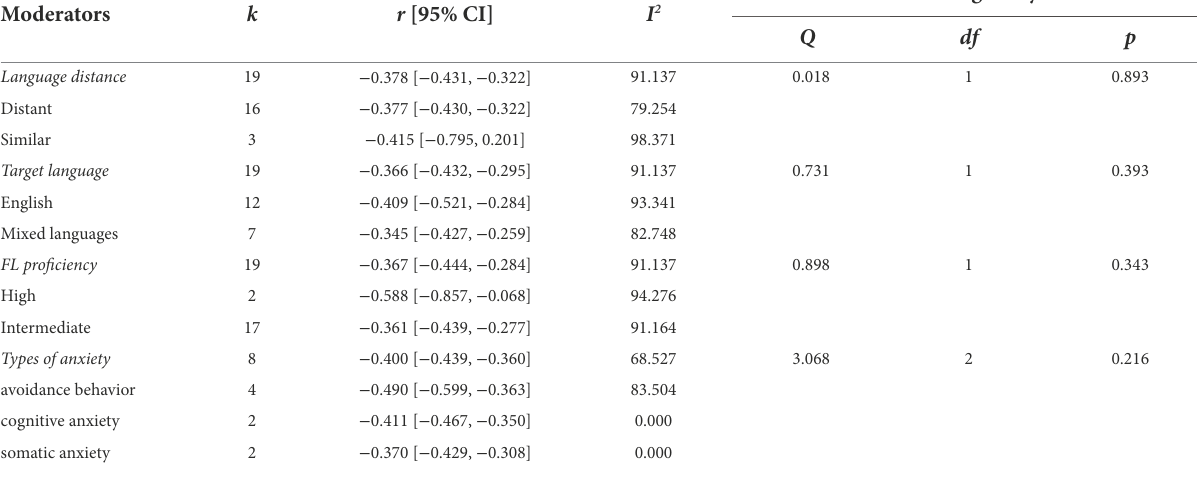
TABLE 5 Moderator analyses for the foreign language writing anxiety–writing self-efficacy